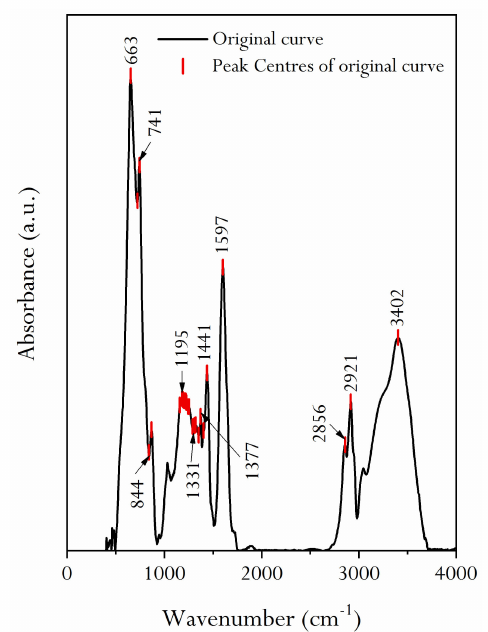
Figure 6. The infrared spectrum of the demineralized HNC.